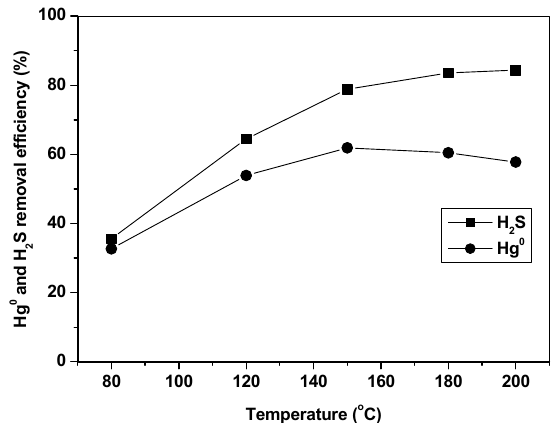
Figure 5. Effect of temperature on Hg 0 and H 2 S removal by Fe10/AC.